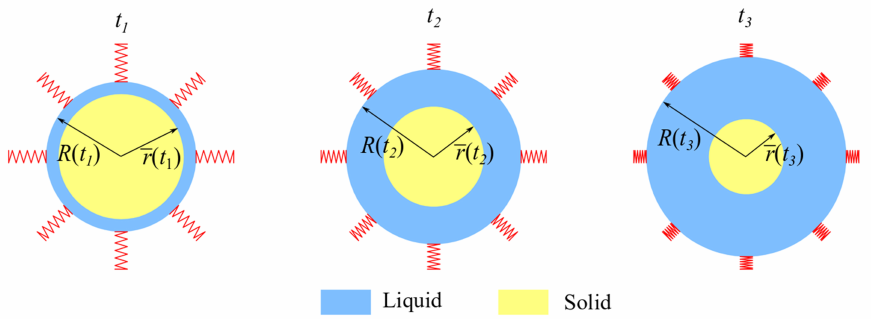
Figure 1. Schematic representation of the time evolution of the melting process. As time evolves, the radius of the solid phase r ( t ) moves inwards and the system size R ( t )